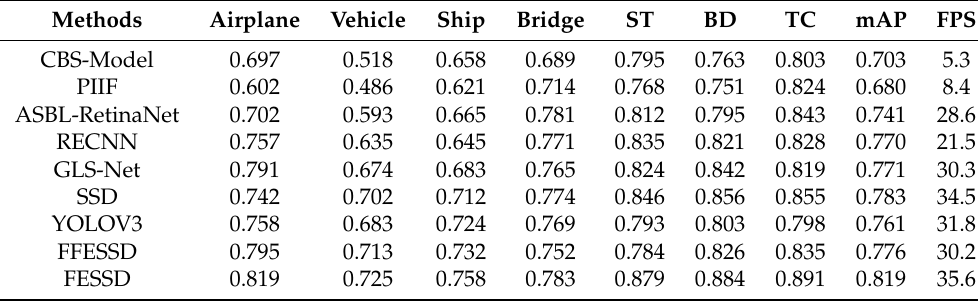
Table 3. The performance comparisons of different methods on the SD-RSI